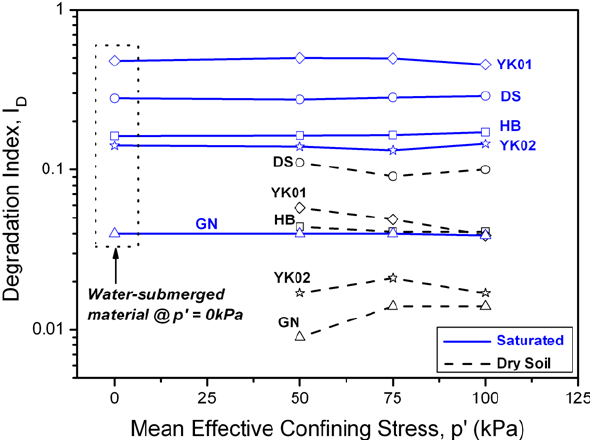
Fig. 8. Effects of confining stress on water-induced granular de- Figure 8. Effects of confining stress on water-induced granular decomposition. 3